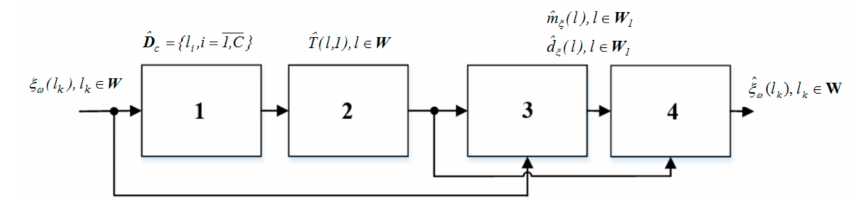
Figure 2. Block diagram of the computer modeling of the microrelief process (known approach): 1—assessment of the segmental structure of the microrelief; 2—assessment of the rhythmic structure of microrelief; 3—statistical processing of microrelief; 4—cyclic microrelief modeling.